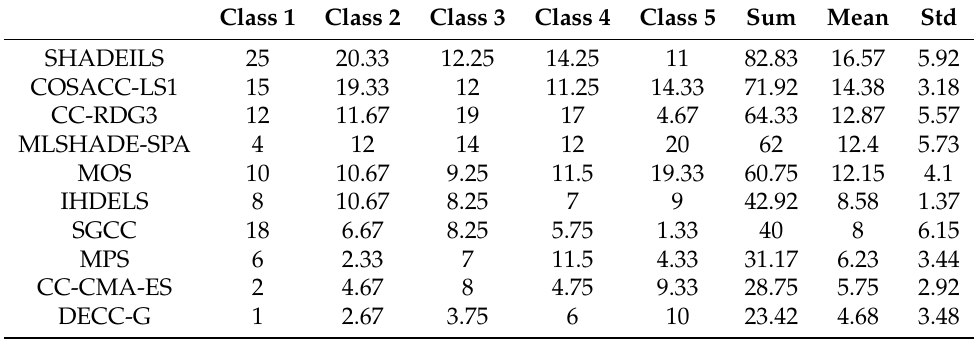
Table 6. Comparison of state-of-the-art